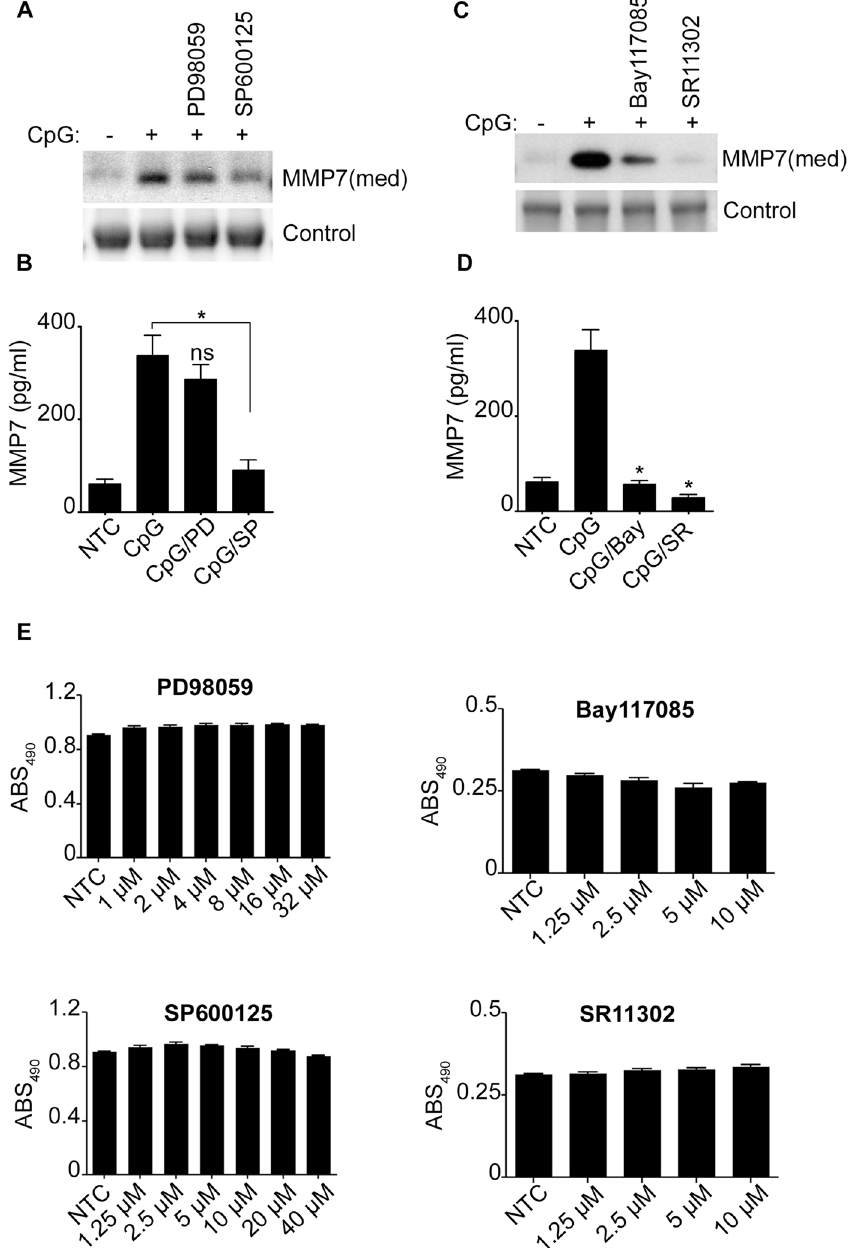
Figure 3. JNK and the transcriptions factors AP-1 and NF- κ B participate in the regulation of MMP7 of CpG-Activated B-lymphocytes. MMP-7 was detected by immunoblotting ( A , C ) or by ELISA ( B , D ) in the cell supernatant (med) of unstimulated or CpG-stimulated cells. Cells were pretreated for one hour with the MAPK inhibitors, 30 μ M PD98059 and 20 μ M SP600125; or the transcription factor inhibitors, 10 μ M Bay 117085 and 10 μ M SR11302. ( D ) Cells were treated with different concentrations of the inhibitors as indicated. XTT was measured after 24 hours. Data are representative of at least three independent experiments. * p < 0.0001, ns, not significant ( p >